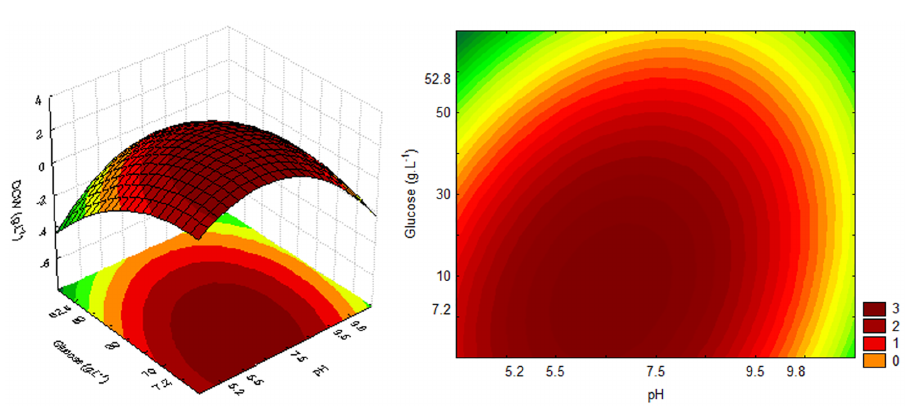
Fig 6. Response and contour surfacesas a function of glucose concentration and pH for DCW.